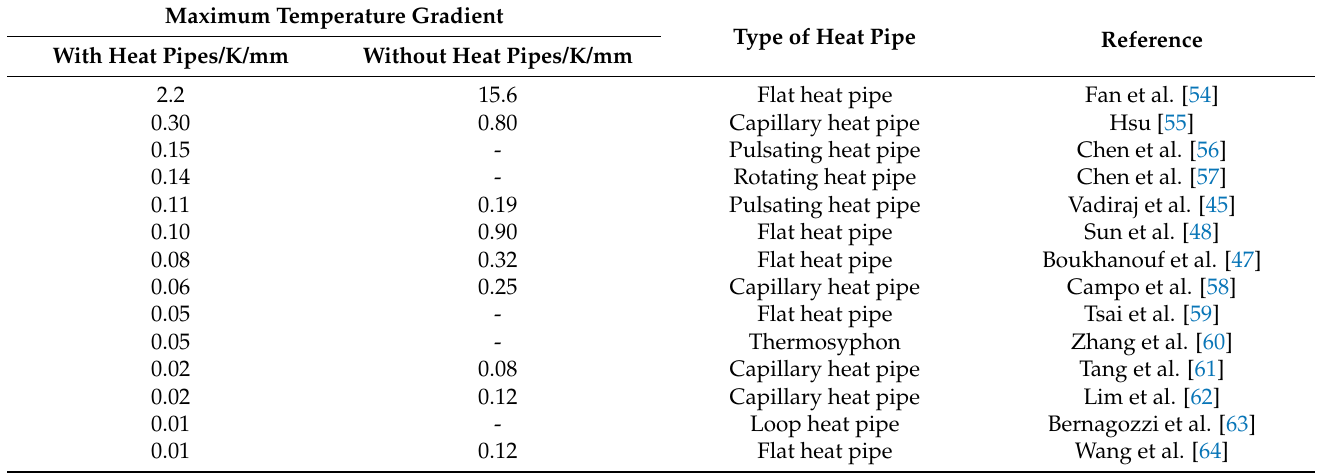
Table 4. Characteristics of heat pipes for isothermal performance in thermal